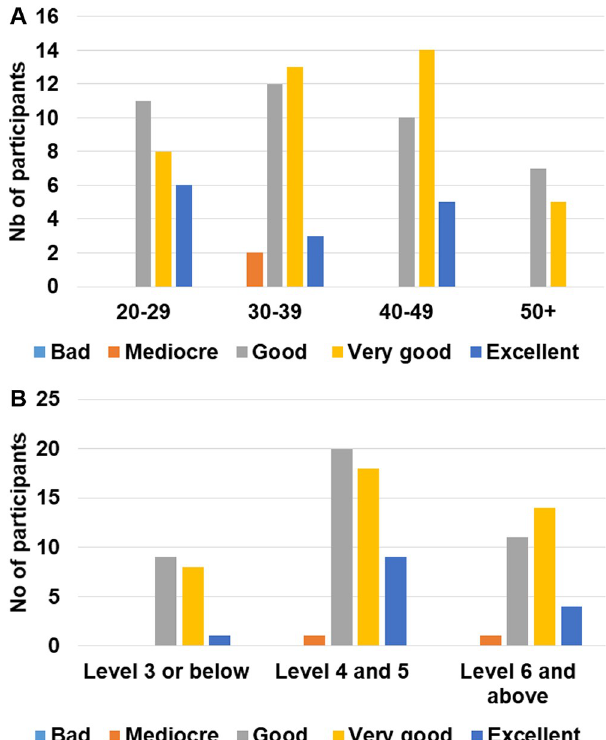
Fig 5. Description of the readability of the test results according to the participants. Number of participants in each rating category according to age (A) or education level (B).